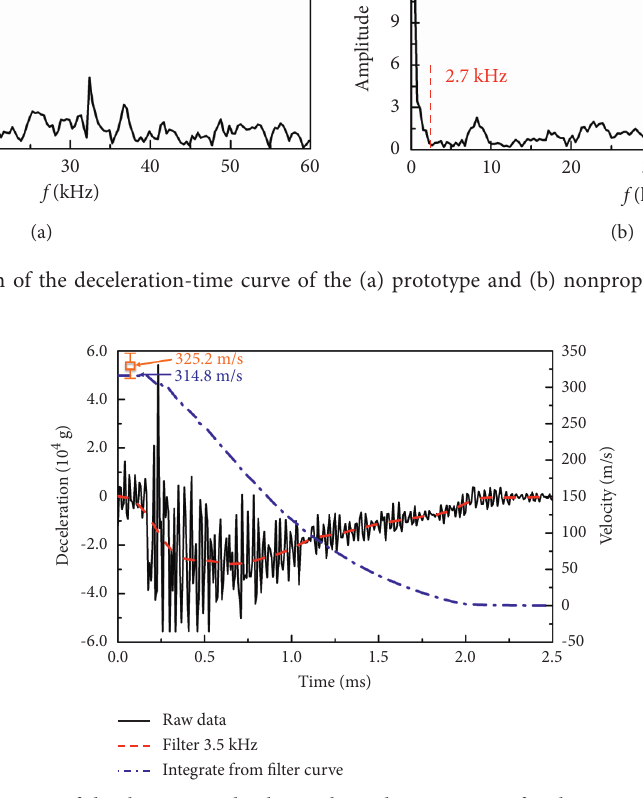
Figure 11: Curve of deceleration and velocity dependence on time for the prototype projectile.